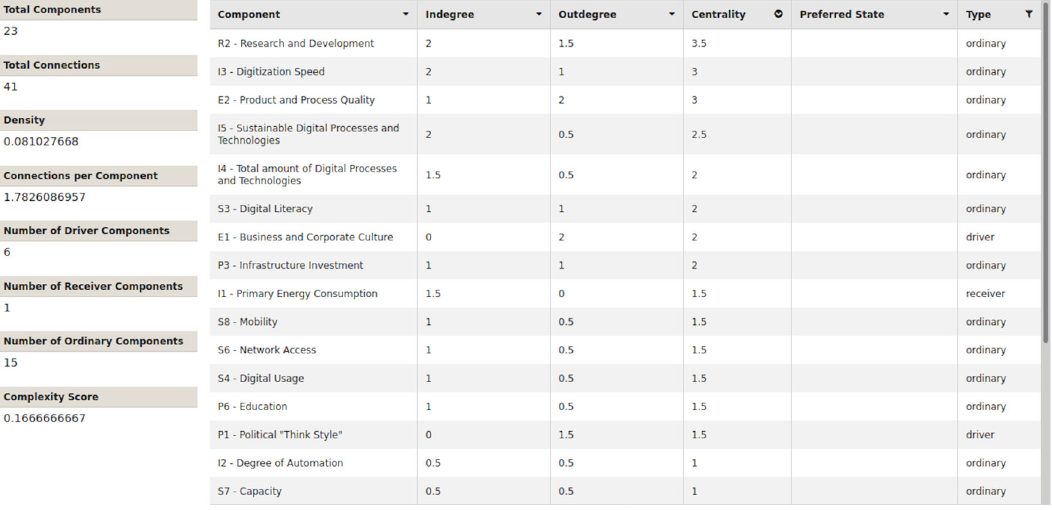
Figure 9. Traditional growth-oriented scenario. Network parameters and centrality (Screenshot from Mental Modeler Software).